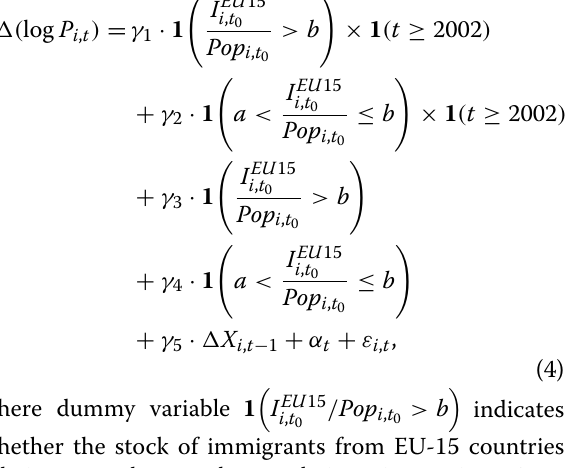
1 where dummy variable indicates whether the stock of immigrants from EU-15 countries relative to the total population in region i at time t 0 < t is above some threshold b ∈ ( 0, 1 ) , and indicates an intermediate